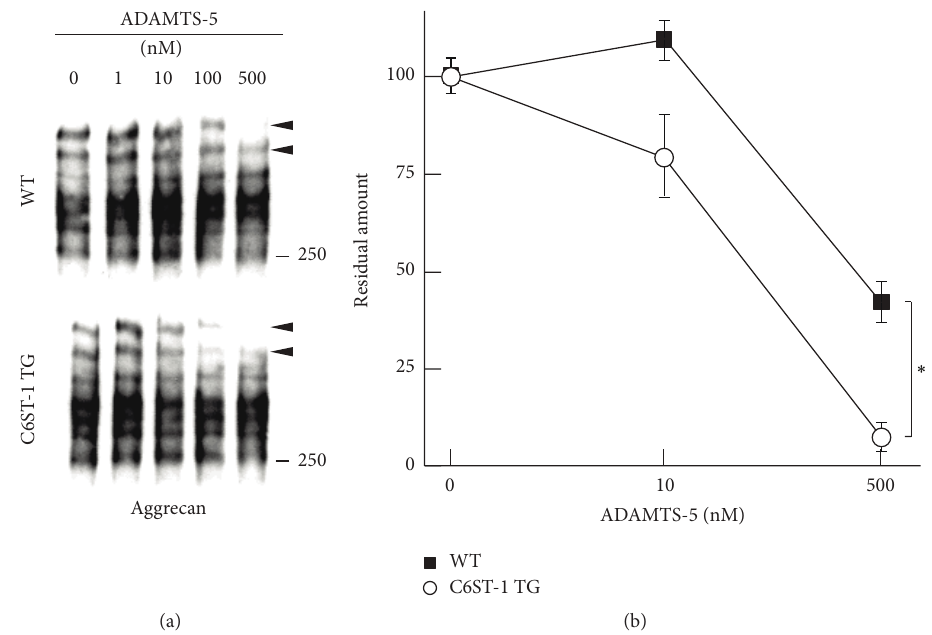
Figure 6: Degradation of aggrecan by ADAMTS-5 in vitro . (a) Whole brain lysate of 6-month-old adult WT or C6ST-1 TG mice was digested with increasing amounts of ADAMTS-5. The concentrations of ADAMTS-5 used for digestion were indicated. Degradation of aggrecan was compared by Western blotting. Two high molecular weight aggrecan bands shown by arrowheads in C6ST-1 TG mice were degraded more efficiently by ADAMTS-5 than those of WT mice. (b) The residual amounts of two high molecular weight bands in WT (filled square) and C6ST-1 TG (open circle) mice were expressed as values relative to the no enzyme control. Asterisks denote significant differences ( 𝑃 < 0.05 , Student’s t -test) between WT and C6ST-1 TG mice. Data ± SEM were obtained from the triplicate